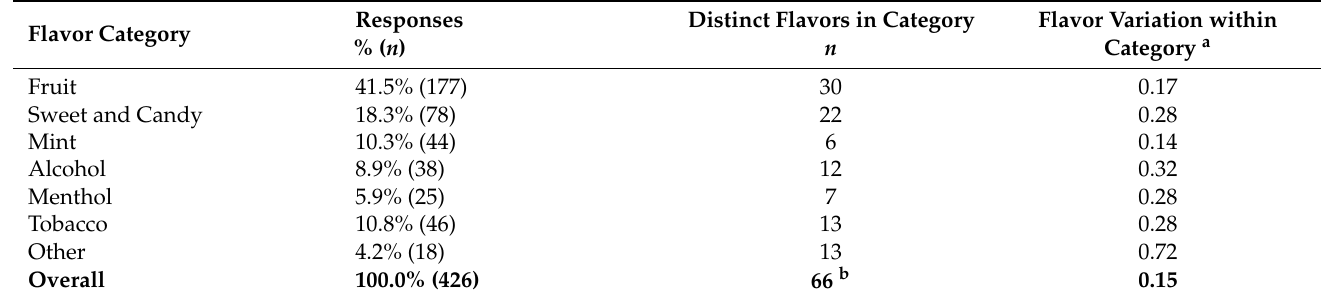
Table 2. Preferred cigarillo flavor category placement and variation ( n =